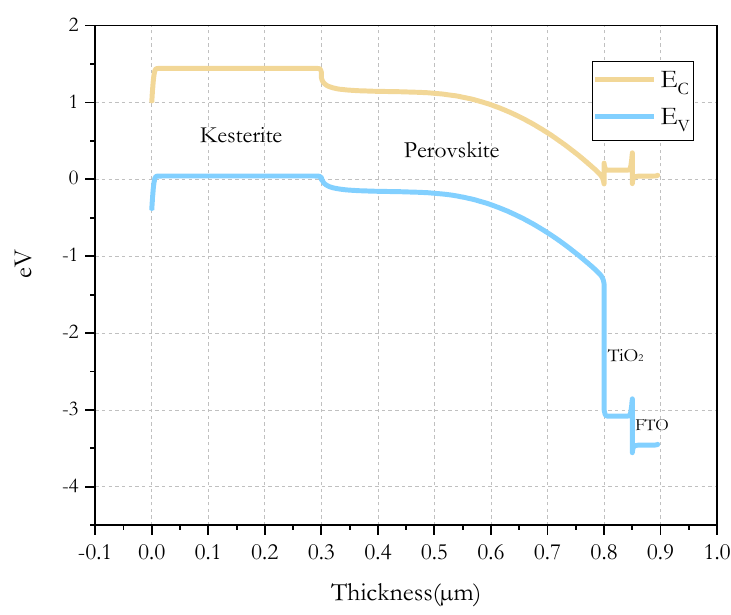
Figure 4. The band diagram of the n−i−p PSC at equilibrium.